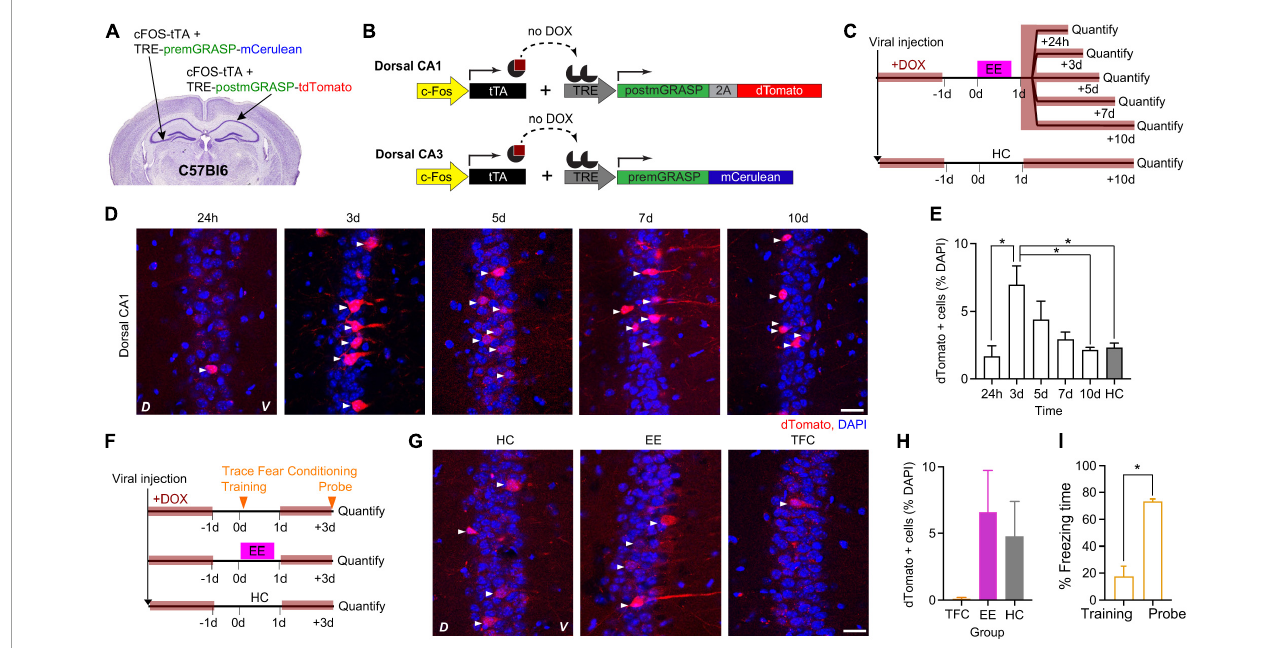
FIGURE2 cFostTA-dependent expression of mGRASP in dCA1 upon exposure to an Enriched Environment or Trace Fear Conditioning. Schematic description of the viral injection sites in WT animals (A) , the viral constructs injected (B) and the experimental design (C) to determine the expression kinetics of post-mGRASP in dCA1 under the control of cFos upon exposure to EE or HC. (D) Confocal pictures, single Z-planes, of dCA1 at different time points after induction of post-mGRASP expression. Red, dTomato; blue, DAPI. White triangles indicate RFP-positive cells. D, Dorsal, V, Ventral. Scale bar = 20 µ m. (E) Percentage of dTomato-expressing over DAPI-positive cells in dCA1 after exposure to EE or HC. The levels of dTomato reached a peak at 3 days ( p 3d - 24h = 0.01, p 3d - 5d = 0.7, p 3d - 7d = 0.3, p 3d - 10d = 0.037, p 3d − HC = 0.048; all n = 5; Kruskal–Wallis test after Dunn’s correction for multiple comparisons). (F) Schematic description of the experimental design to determine the dCA1 expression levels of post-mGRASP under the control of cFos upon exposure to TFC, EE, or HC. (G) Confocal pictures, single Z-planes, of dCA1 at different time points after induction of post-mGRASP. Red, dTomato; blue, DAPI. White triangles indicate dTomato-positive cells. D, Dorsal, V, Ventral. Scale bar = 20 µ m. (H) The percentage of dTomato-expressing over DAPI-positive cells in dCA1 was not significantly different after exposure to TFC, EE or HC ( p TFC − HC = 0.41 and p EE − HC = 0.26, all n = 6; Kruskal–Wallis test after Dunn’s correction for multiple comparisons). (I) Percentage of freezing time during the context probe 3 days after TFC training ( p = 0.03, n = 6; Wilcoxon Signed-rank test). * p < 0.05.